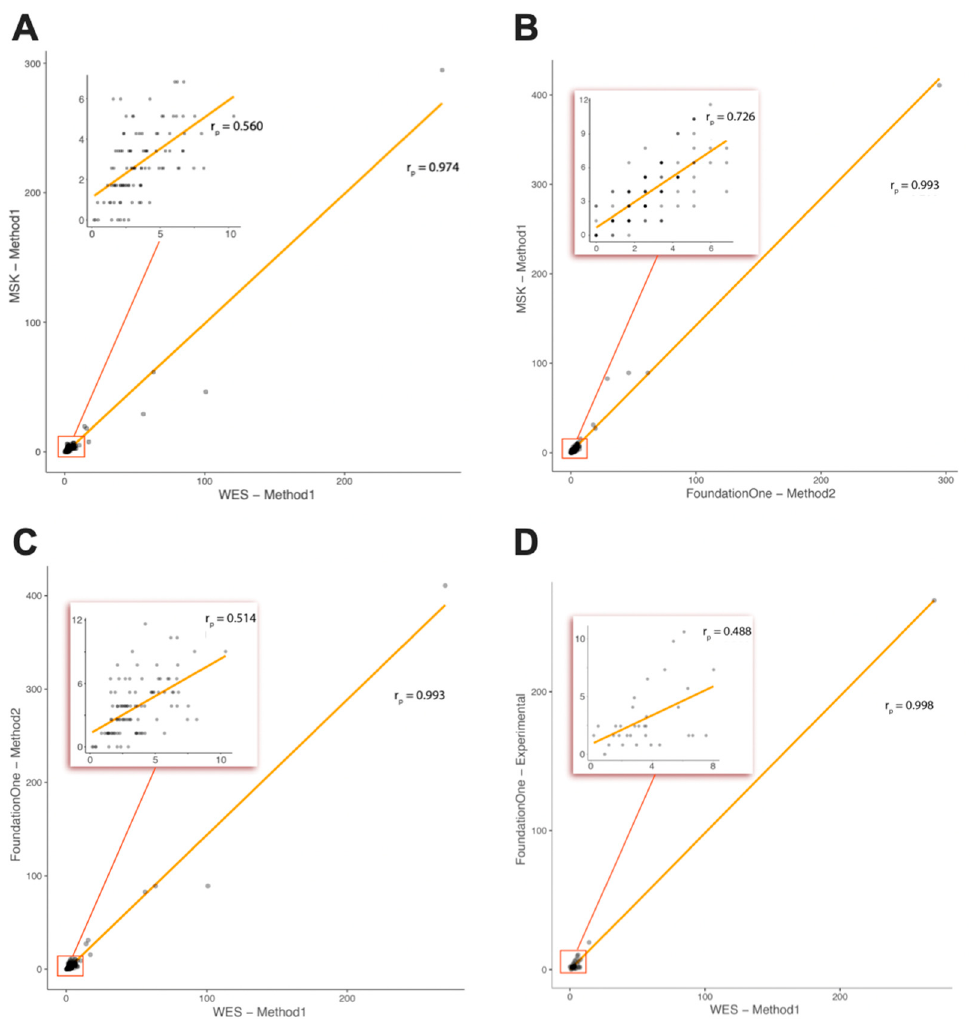
Figure 2. Correlation of tumor mutational burden (TMB) determined by real-life WES and targeted gene panels: real-life WES vs. in silico MSK-IMPACT ( A ), in silico F1CDx vs. MSK-IMPACT ( B ), real-life WES vs. in silico F1CDx ( C ), real-life WES vs. real-life laboratory service F1Heme ( D ).